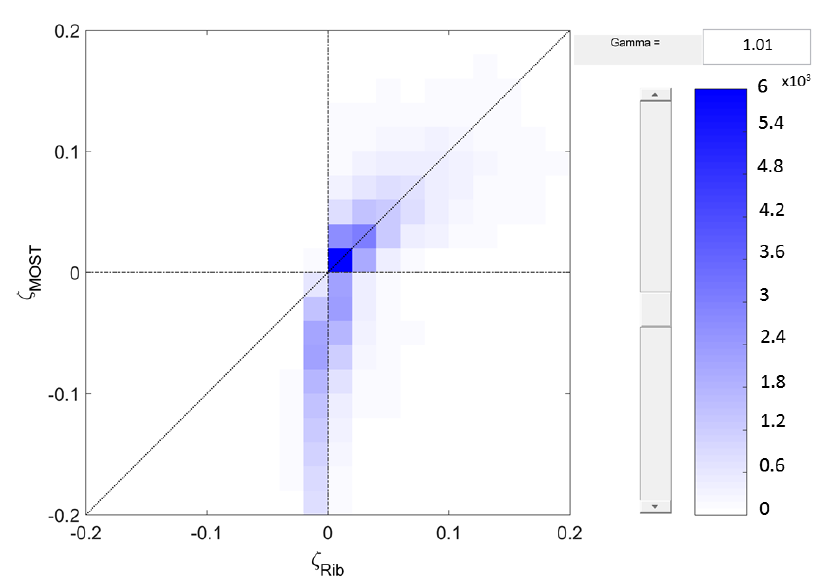
Figure 3. ζ MOST evaluated by direct measurements and ζ Rib obtained from averaged values compared